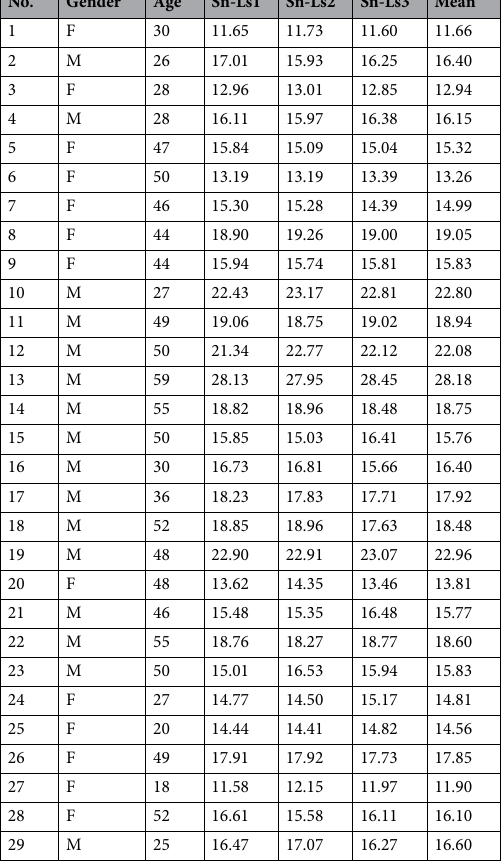
Table 2. Measurements of Sn-Ls in the healthy control